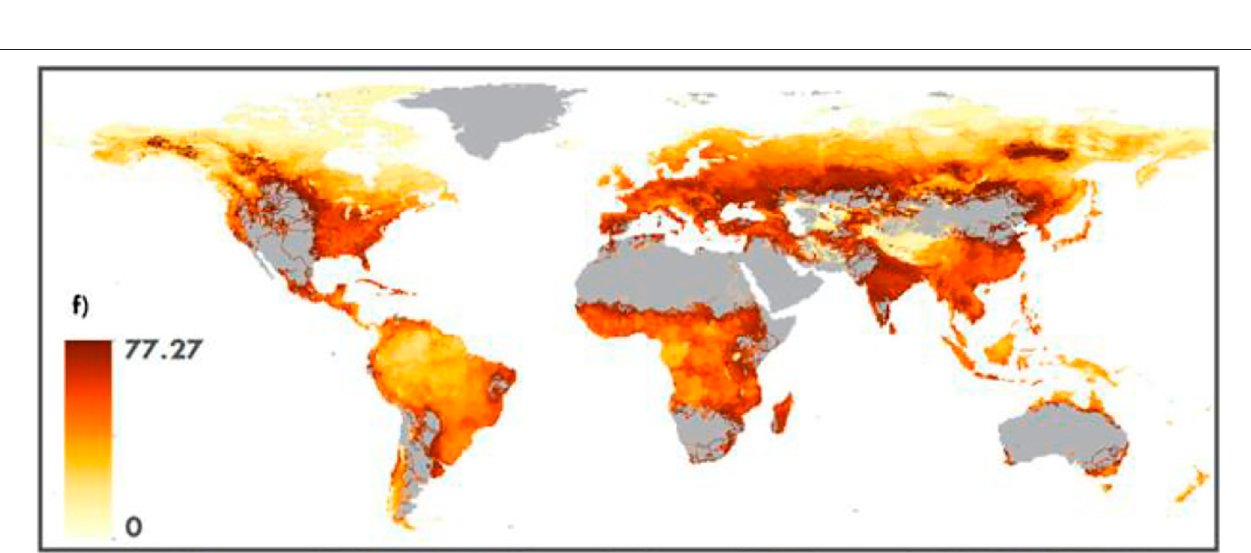
Frontiers in Environmental Science |